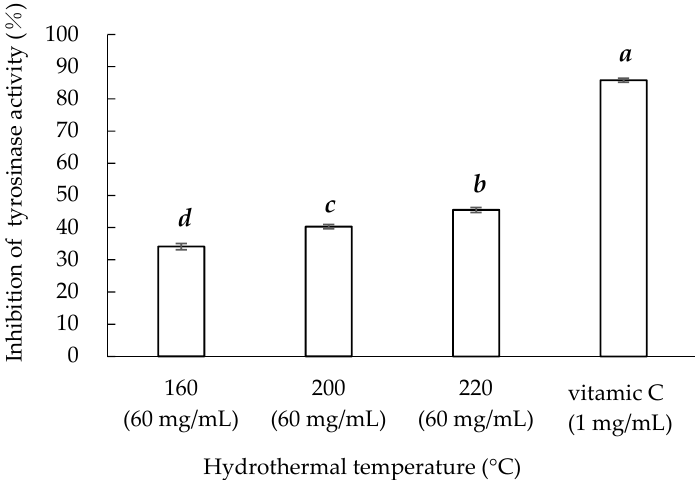
Figure 7. Hydrothermal extraction temperature and tyrosinase inhibition activity of sericin extracts.